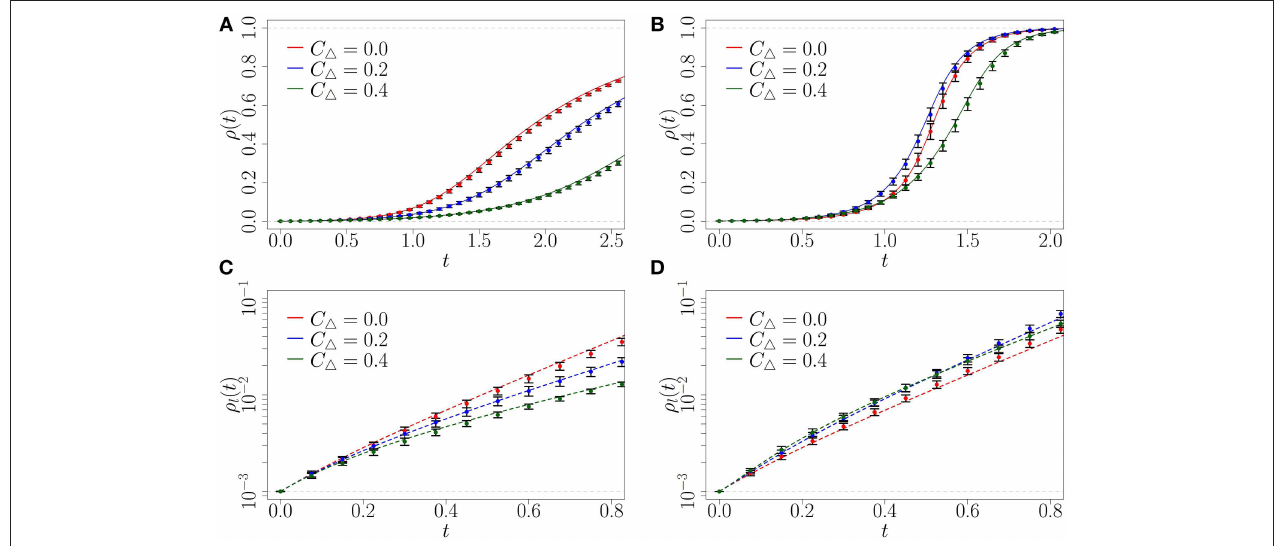
FIGURE 6 | Fraction ρ ( t ) of infected nodes from CA and linearized solution, compared with Monte Carlo simulations (symbols), on random (red), moderately clustered (blue), and highly clustered (green) networks. (A) β Symbols represent the mean of 10 Monte Carlo realizations (the error bars indicate one standard deviation above and below the mean), solid lines represent the CA results, and dashed lines the linearized approximation. Note that the y-axis of (C,D) are logarithmic. The initial fraction of infected is ρ 0 sizes are N 10 5 , using step size dt 10 − 3 . = =